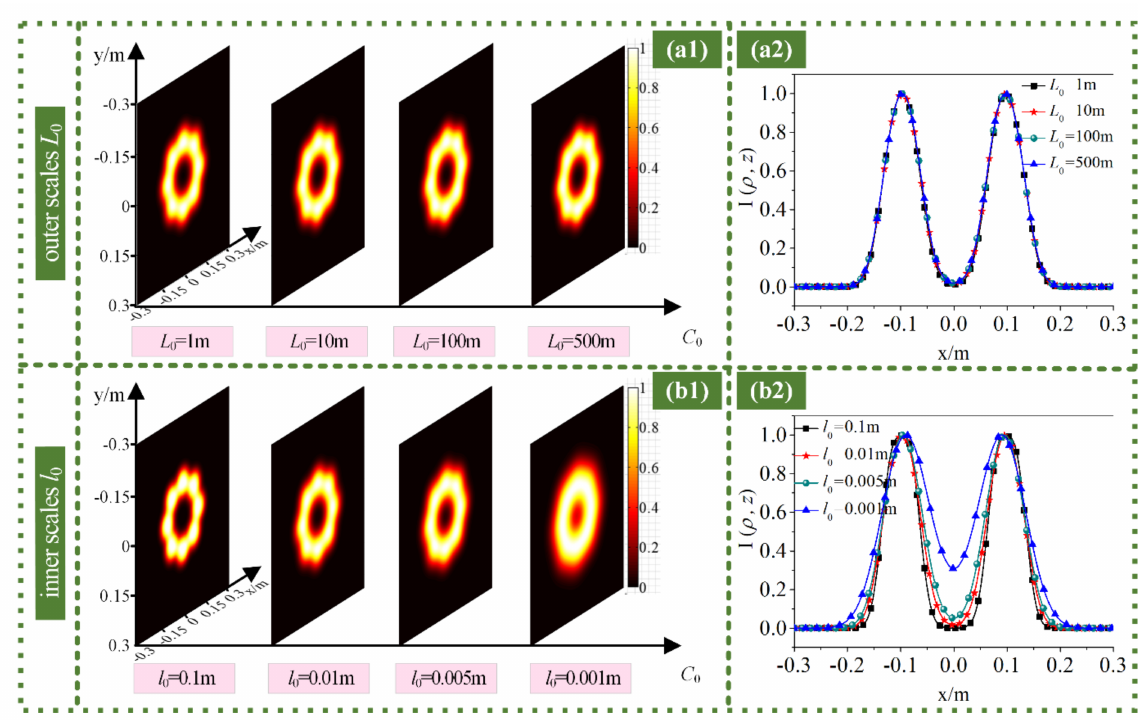
Figure 9. Intensity ( a1 , b1 ) distributions and ( a2 , b2 ) profiles of RPLPCV beam array through non-Kolmogorov turbulence for different ( a ) outer scales L 0 and ( b ) inner scales l 0